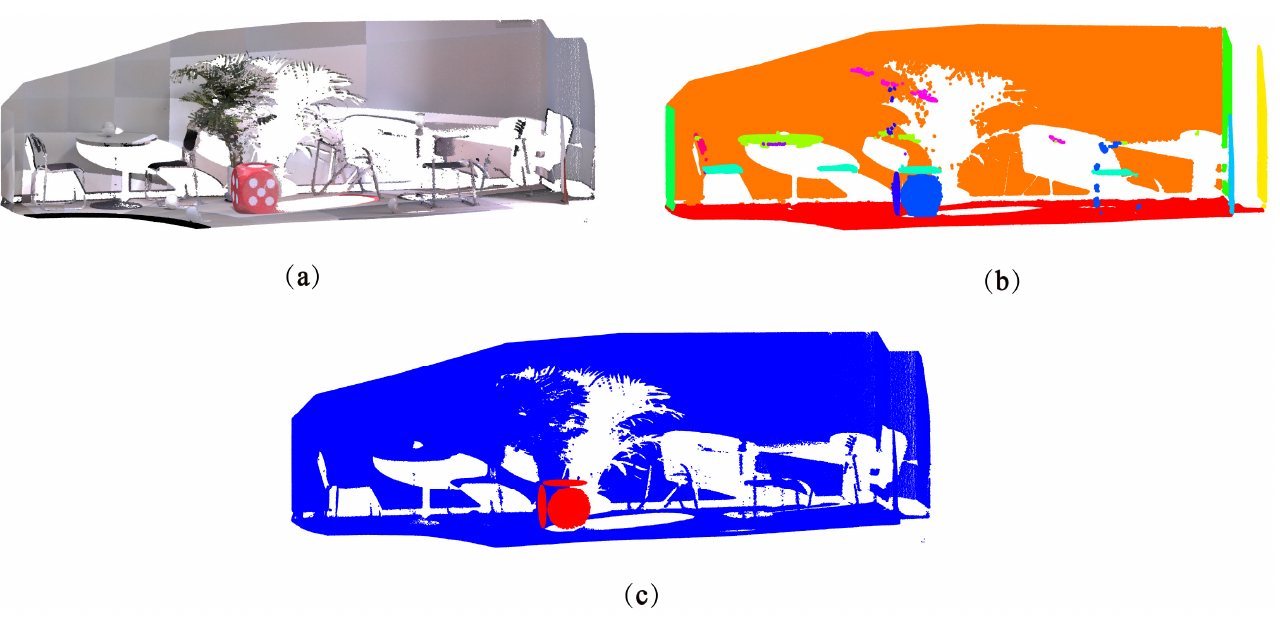
Figure 5. Key steps of the automatic target (die) extraction. The NDT-RANSAC is adapted for the planar feature segmentation. ( a ) Original point cloud. ( b ) NDT-RANSAC plane segmentation. ( c ) Extracted die.